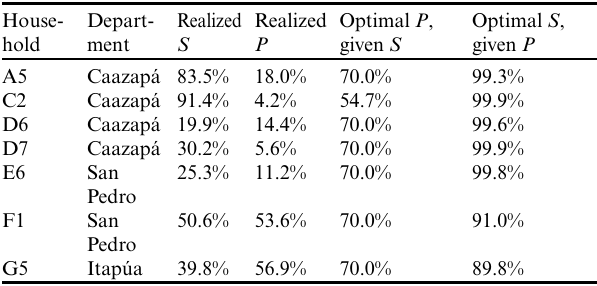
Table 6 . Realized and potential production of supporting ( S ) and provisioning ( P ) ecosystem services for selected